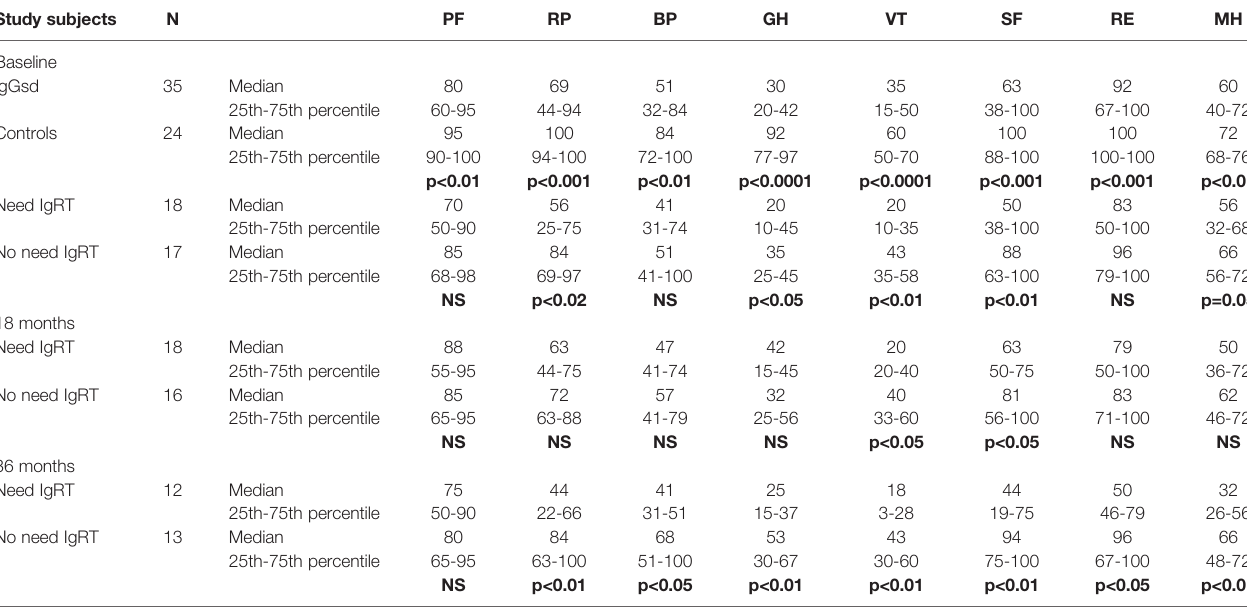
TABLE 2A | SF-36 health-related quality of life in IgGsd and controls at different time points. Study subjects N PF Baseline IgGsd